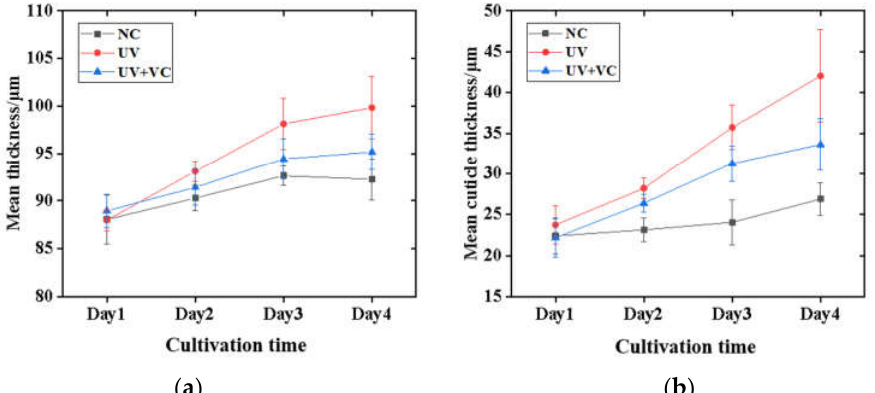
Figure 5. ( a ) Mean skin thickness for each group of AS with time; ( b ) mean cuticle thickness for each group of AS with time.